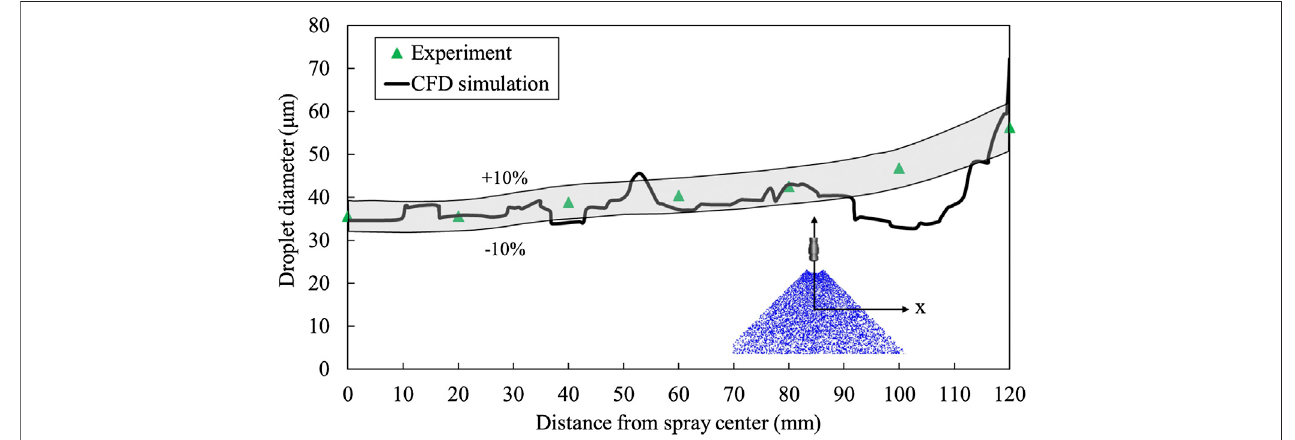
FIGURE 7 | Comparison of droplet size at different locations within a spray.